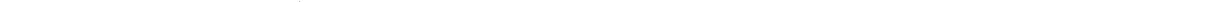
Fig. 1 Lefty1 expression in L1 epi and L1 dve cells is regulated by Nodal-Foxh1 signaling. a Expression of three Lefty1 transgenes ( L1-DE + PE + -mVenus , L1-DE m PE + -Cherry , and L1-PE + -Venus ) was examined in mouse embryos at E3.5 and E4.5. Embryos were immunostained for transgene expression as well as for GATA6 (a PrE-speci fi c marker), and they were counterstained with 4 ’ ,6-diamidino-2-phenylindole (DAPI). Bright- fi eld images are also shown. The expression pattern of L1-DE + PE + -lacZ in wild-type embryos has been described previously 8 . The number of cells in each embryo is indicated. Scale bars, 50 μ m. b Structures of various Lefty1 reporter transgenes and summary of their activities at the indicated stages. L1-BAC is the Lefty1(mVenus) BAC transgene generated by replacement of lacZ in the Lefty1(lacZ) BAC transgene 9 with mVenus . The positions of two Foxh1-dependent enhancers, DE (distal enhancer) and PE (proximal enhancer), are indicated. The Foxh1-binding sites in DE or PE are mutated in L1-DE m PE and L1-PE m , respectively. c The expression of L1-DE + PE + -lacZ was examined by X-gal staining in Nodal +/+ and Nodal – / – embryos at the indicated stages. Scale bars, 50 µ m. d L1-DE m PE + -Cre or L1-2.2-Cre transgenic mice were crossed with Rosa26R transgenic mice, and transgenic embryos recovered at E5.5 or E6.5 were stained with X-gal. Two types of embryos were observed for the L1-DE m PE + -Cre cross: type I (8/24 embryos), in which only DVE and DVE-derived cells were marked at E5.5 and E6.5, respectively; and type II (16/24 embryos), in which the extraembryonic region was positive in addition to DVE and DVE-derived cells at E5.5 and E6.5. DVE-derived cells were detected on the lateral side of E6.5 embryos produced from the L1-2.2-Cre cross (6/7 embryos). The number of DVE-derived cells was increased in E6.5 embryos produced from a cross of L1-2.2-Cre mice with Lefty1,2 – / – mice expressing Rosa26R (2/3